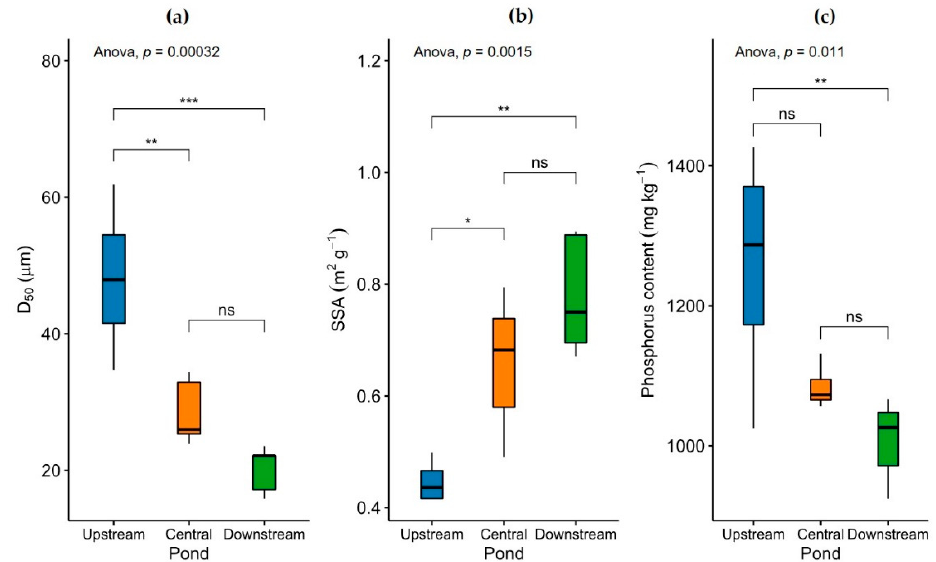
Figure 8. Boxplots showing the range of ( a ) D 50 ( μ m), ( b ) SSA (m 2 g − 1 ) and ( c ) phosphorus content (mg kg − 1 ), of sediment in each pond from trap deployment during March 2019 (Upstream Pond n = 4; Central Pond n = 5; Downstream Pond n = 5). Median values are represented by bold lines and significance levels for Tukey’s tests by *** ( p < 0.001), ** ( p < 0.01), * ( p < 0.05), ns ( p > 0.05).